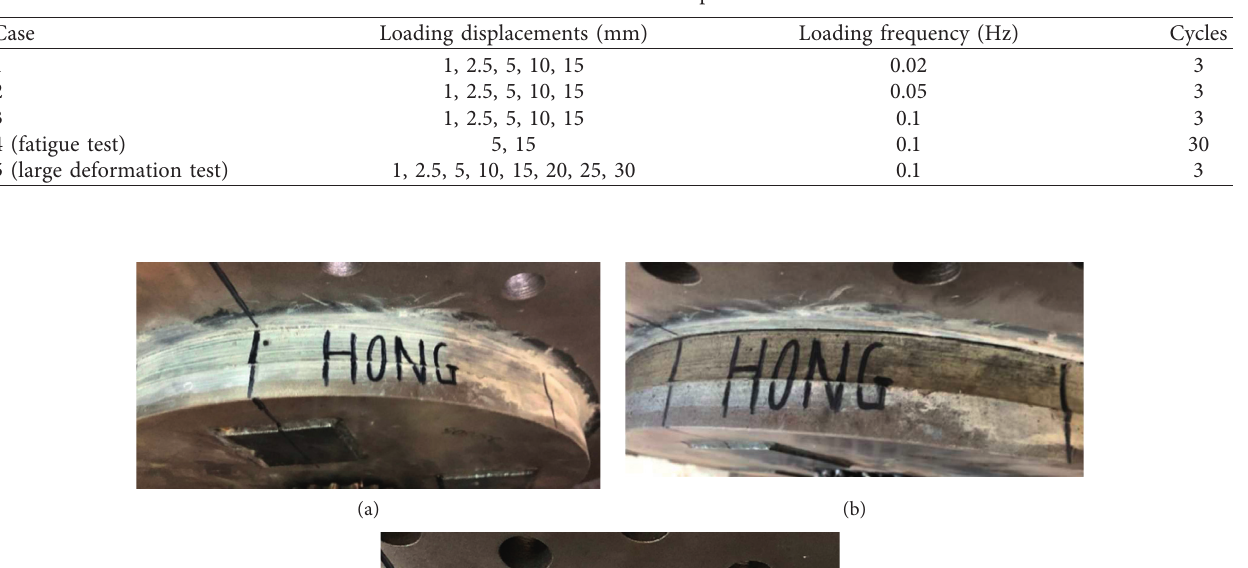
Figure 7: Measurement Table 3: Five cases in the experiment.